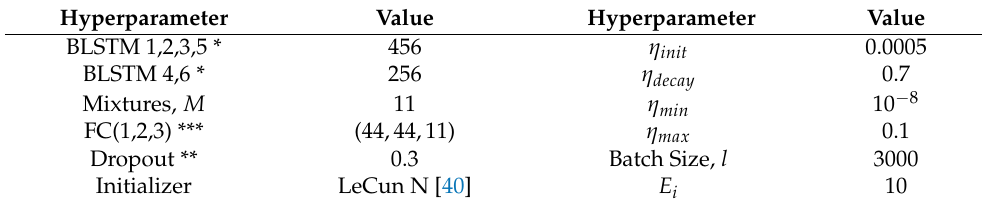
Figure 2. Proposed Deep Learning model with the Bidirectional Long Short Term Memory (BLSTM) model parameterising the temporal dependency and the Mixture Density Network (MDN) model describing the underlying distribution: The input to the BLSTM layers, ˜ x ( l ) are batches of l same-size samples shown in Figure 1. Six BLSTM layers are used, each followed by a dropout layer and Batch Normalisation. Three Fully Connected (FC) layers are used to parameterise the features of the Probability Density Function (PDF). The PDF is then used to predict the target for each sample in the batch, ˆ y ( l ) . Table 1. Values of hyperparameters for each part of the model shown in Figure 2 with * corresponding to hidden units in a LSTM, ** is the dropout probability and *** the number of neurons in the respective FC